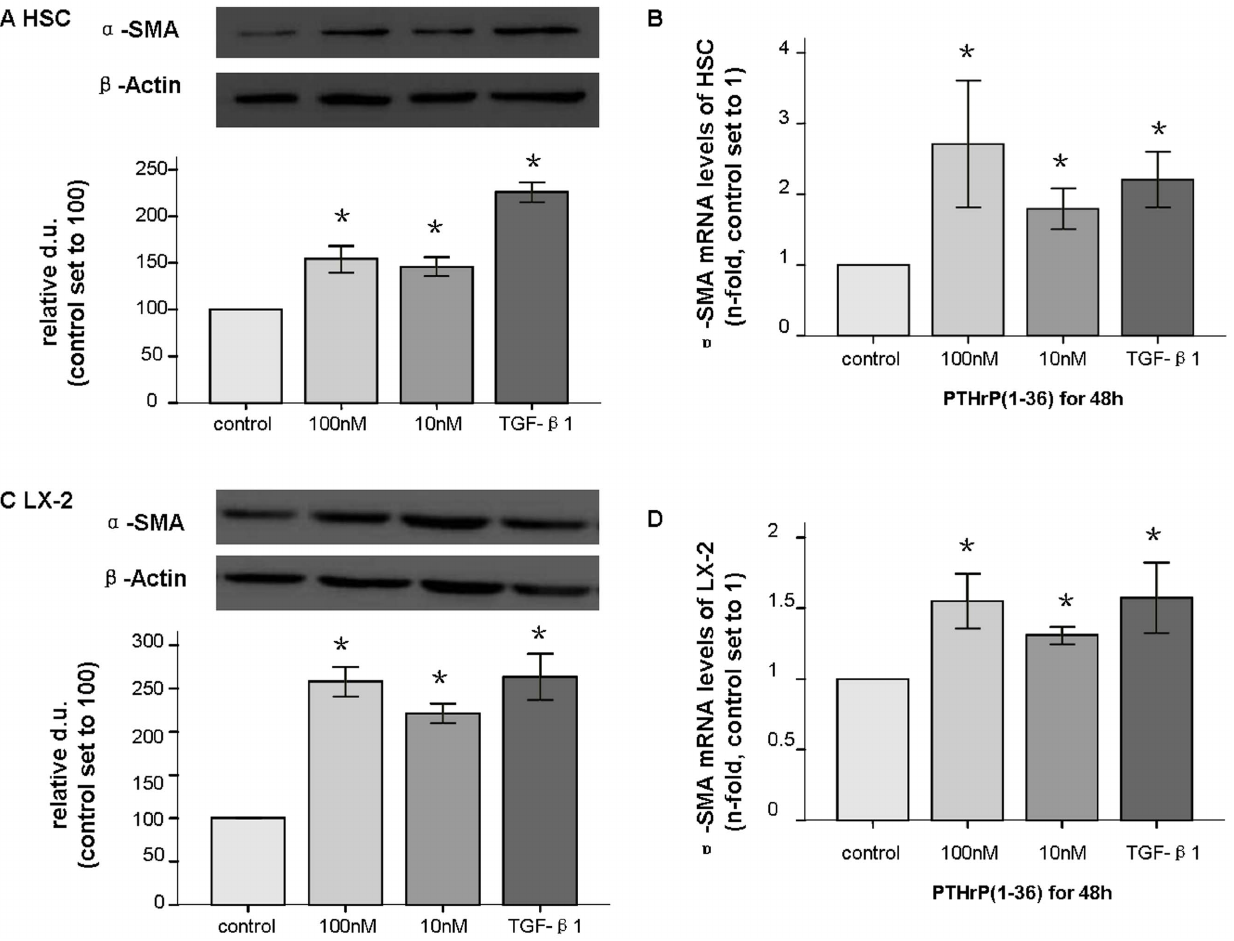
Figure 2. Increased production of a -SMA in HSC and LX-2 cells after PTHrP(1–36) treatment. After treatment with 100 nM of PTHrP(1–36) for 48 h, the a -SMA protein (43 kd) levels assessed by western blot (A) and mRNA levels measured by q-PCR were increased in HSCs (B). The same patterns were observed in LX-2 (C and D). * p , 0.05 compared to the control group.